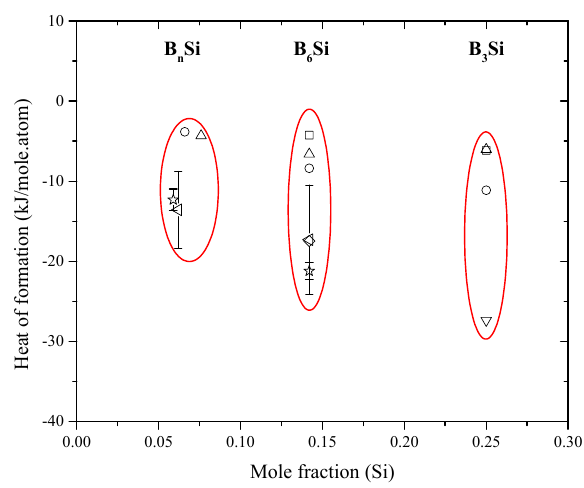
Figure 13. Enthalpy of formation of intermetallic compounds of the B-Si phase diagram; □ : [155]; ○ :